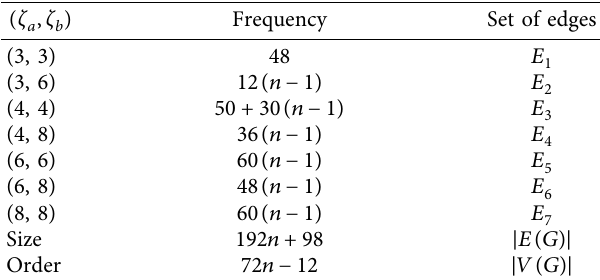
Table 1: Edge partition of L ( MON ( n ))